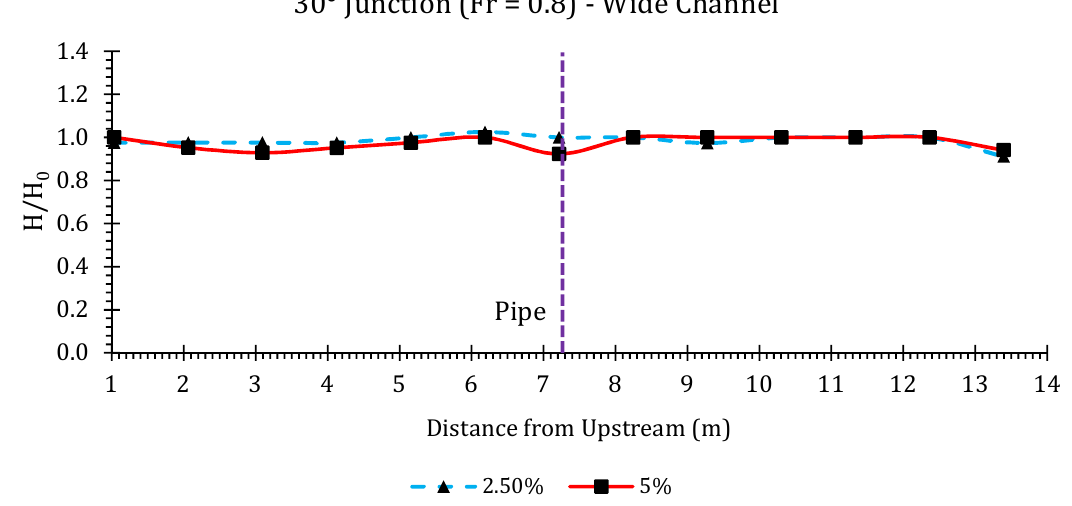
Figure A1. Water height ratios in a 30° junction for Fr = 0.8 in the wide channel.